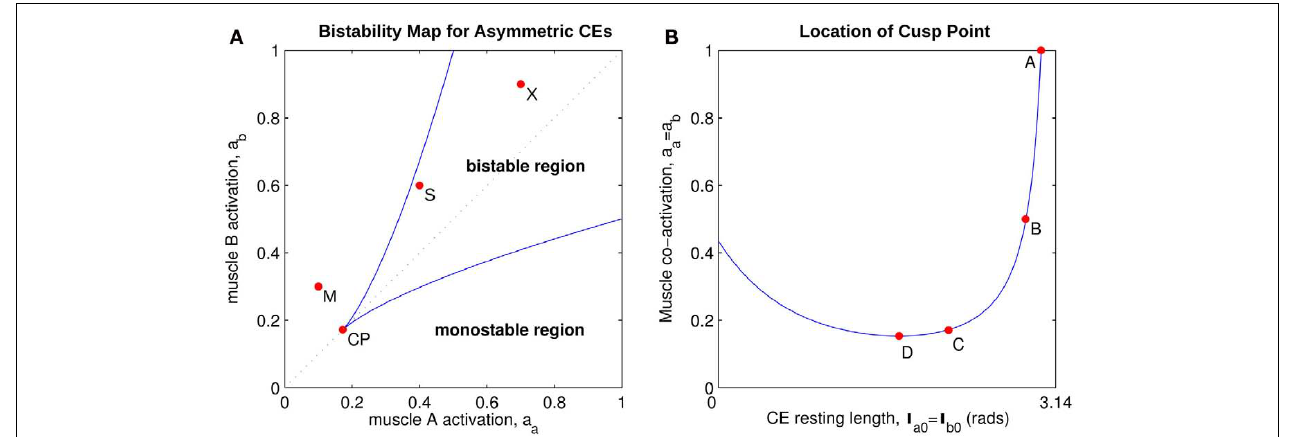
FIGURE 5 | (A) Bistability map for the isolated limb segment with asymmetric CE force-length properties ( θ 0 = π − 1). Solid lines indicate the transition boundary between bistable and monostable regions. Dotted line indicates balanced co-contraction ( a a = a b ). Cusp point (CP) marks the furthest extent of the bistable region ( a a = a b = 0.171). Points M, S, and X correspond to the conditions of medium, strong, and extreme co-contraction applied in Experiments 1 and 2. (B) Shows the migration of the cusp point along the line